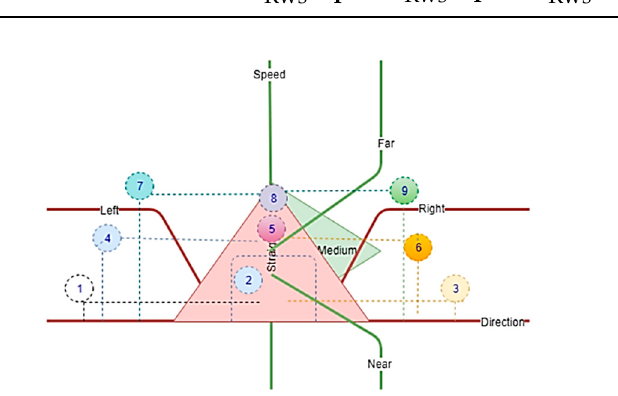
Figure 12. Graphical distribution of the rule table.